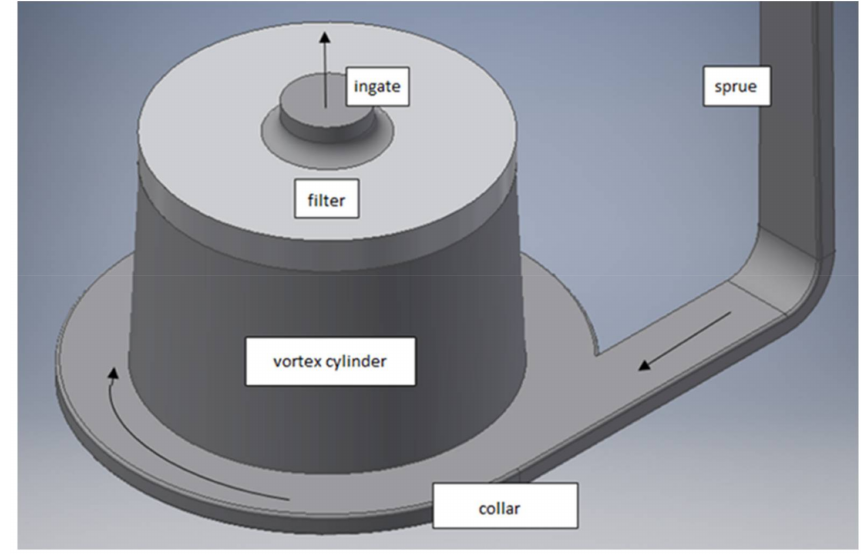
Figure 6. Vortex gate system